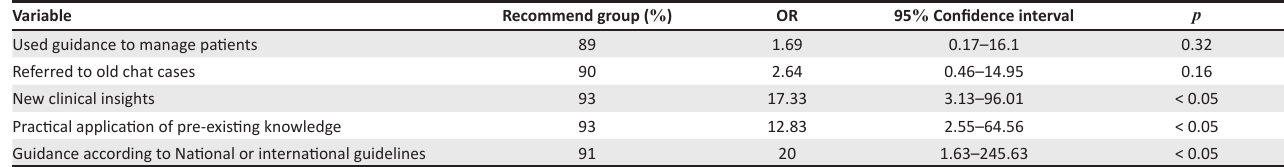
TABLE 4: Clinician recommendation of the WhatsApp group based on their perceived usefulness of it as a learning tool ( n = 91). Variable